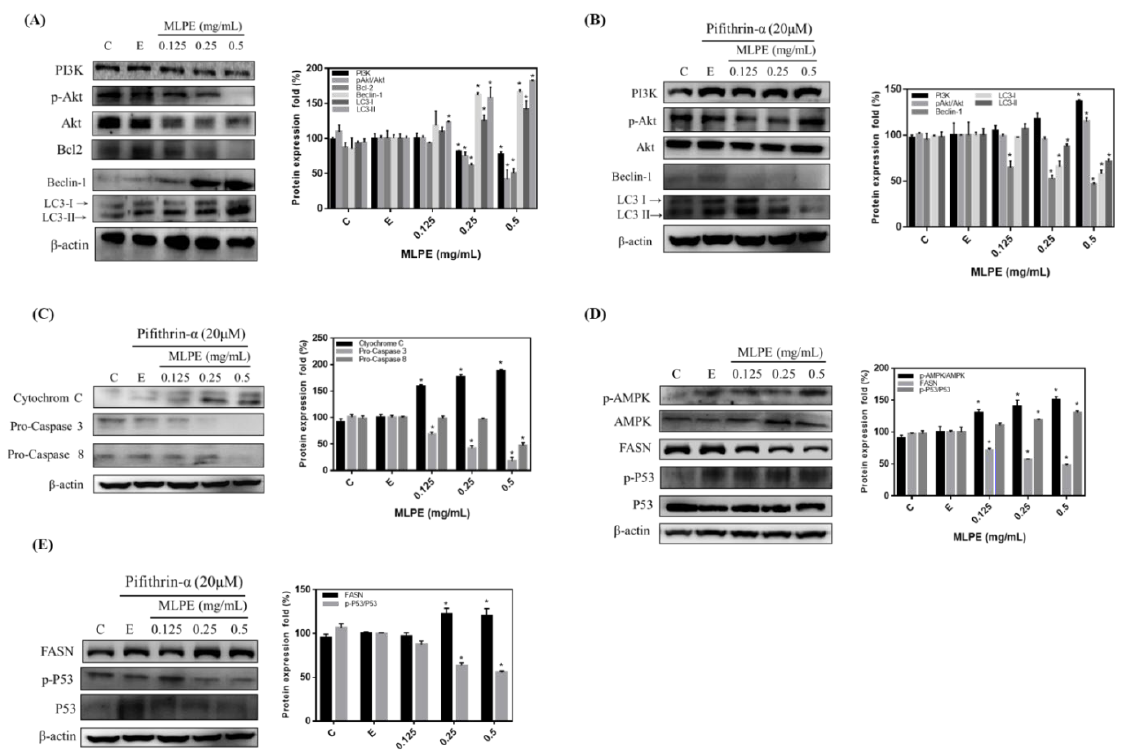
Figure 3. Immunoblot analysis of the autophagosome induction of autophagy in HepG2. Cultured cells were treated with 0, 0.125, 0.25, 0.5 mg/mL of MLPE, PFT α for 6 h and treated with various concentrations of MLPE and solvent (0.05% EtOH) for 24 h, and whole-cell extracts were prepared as described in Materials and Methods. Equal amounts of total proteins were loaded in each lane of SDS-polyacrylamide gel (protein concentration is 50 µ g/ µ L). Western hybridization was performed with antibodies against ( A , B ) PI3K, p-Akt/Akt, Bcl-2, Beclin-1, LC3-I, and LC3-II. ( C ) Cytochrome C, pro-caspase 3, and pro-caspase 8. ( D , E ) p-AMPK/AMPK, FASN, and p-P53/P53. Western blot analysis of β -actin was used as an internal control and represents the average of three independent experiments ± SD, n = 3. *, p < 0.05 compared with ( E